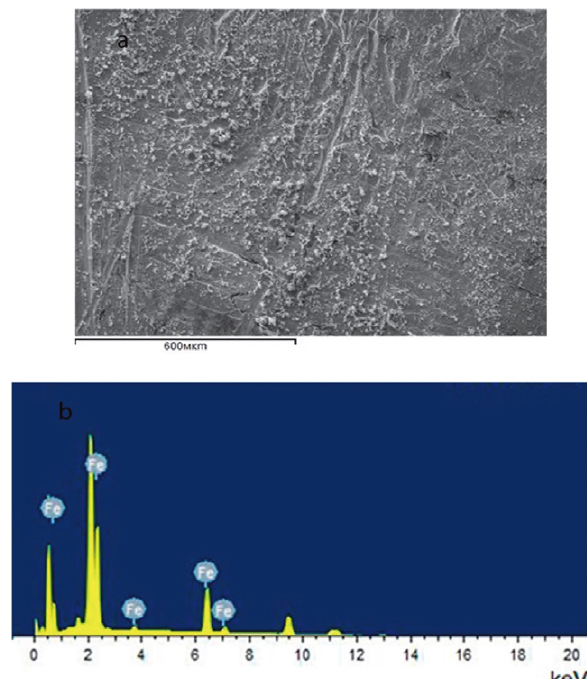
Fig. 9. The image of SEM (a) and EDAX analysis (b) of electrodep- osited iron from the 0.1 М Fe (NO 3 ) 3 × 9H 2 O + CH 2 OH- CH 2 OH electrolyte on the Ni electrode. At E V = 0.02 V / s, and T = 293